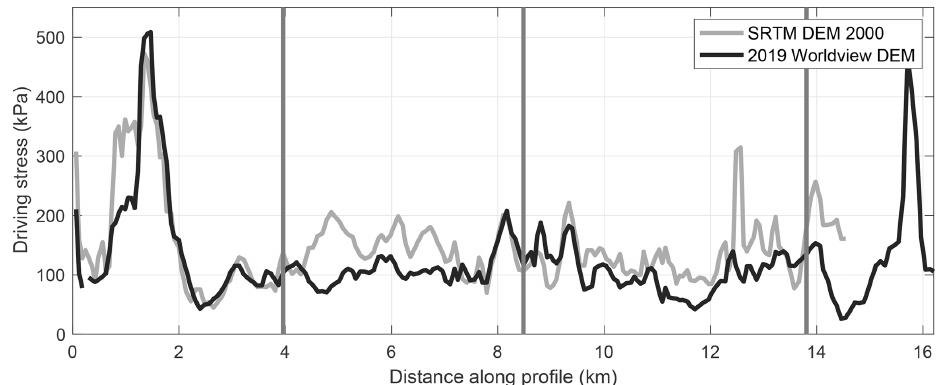
Figure 9. Driving stress profiles as a function of DEMs before (SRTM) and during (Worldview 2019) the surge. Vertical lines show the different sections of the glacier, from left to right, the icefall, the upper trunk, the main trunk, and the terminus (see Fig. 2).